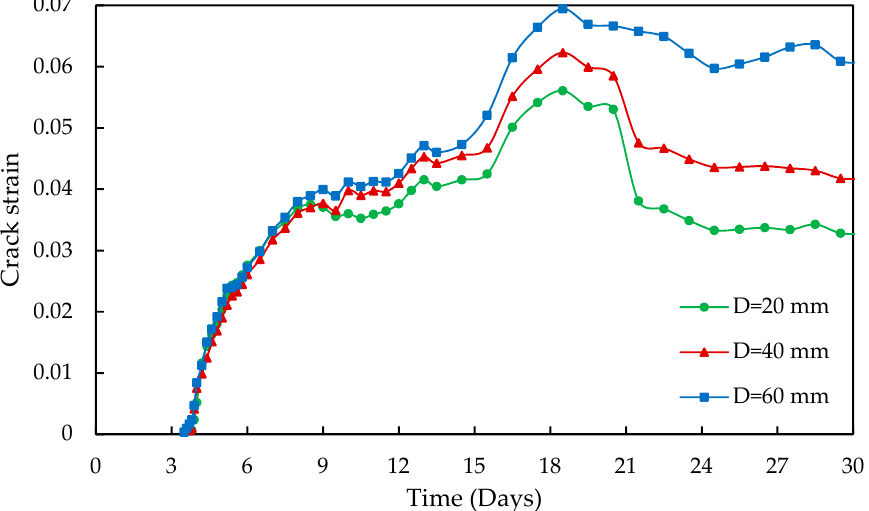
Figure 12. Comparison of maximum steel stress over along the length of the longitudinal steel bar for different saw-cut depths.